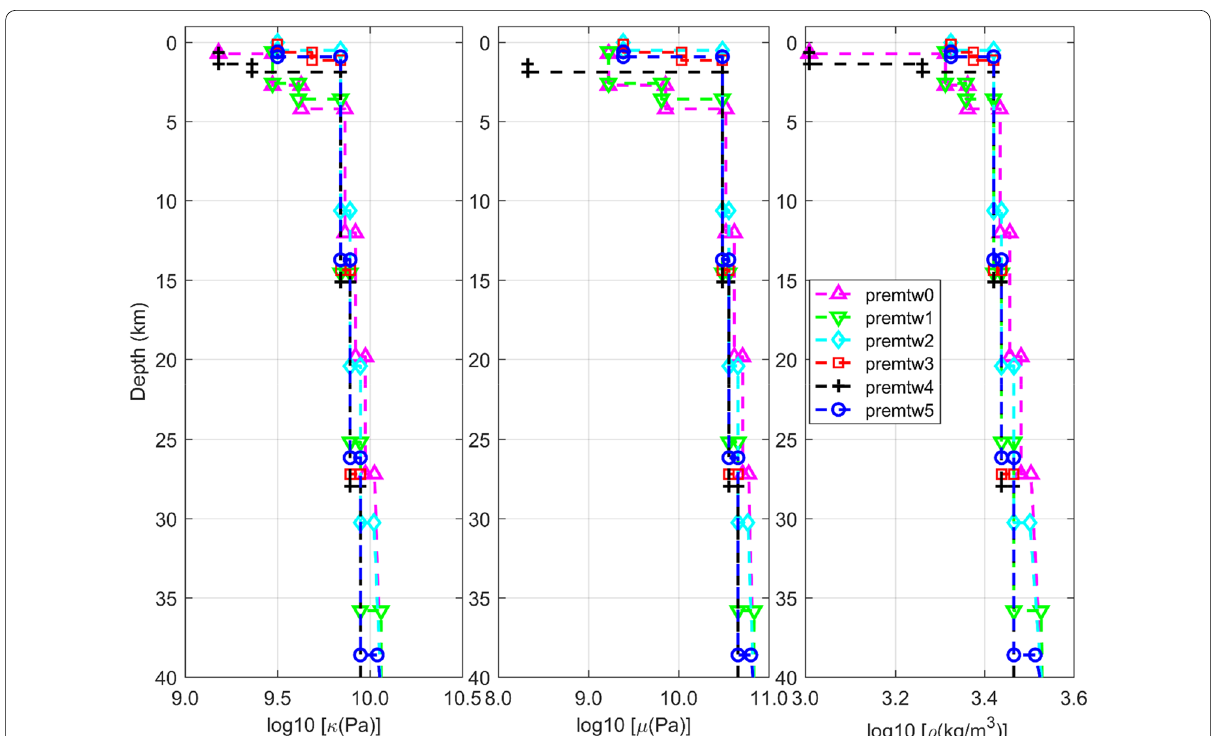
Fig. 2 Six sets of crustal structures from the CRUST1.0 model. TW0 (magenta upright triangle and dashed lines), TW1 (green inverted triangle), TW2 (cyan diamond), TW3 (red square), TW4 (black plus sign), and TW5 (blue circle). Profiles of the bulk modulus (left), shear modulus (middle), and density (right) at different